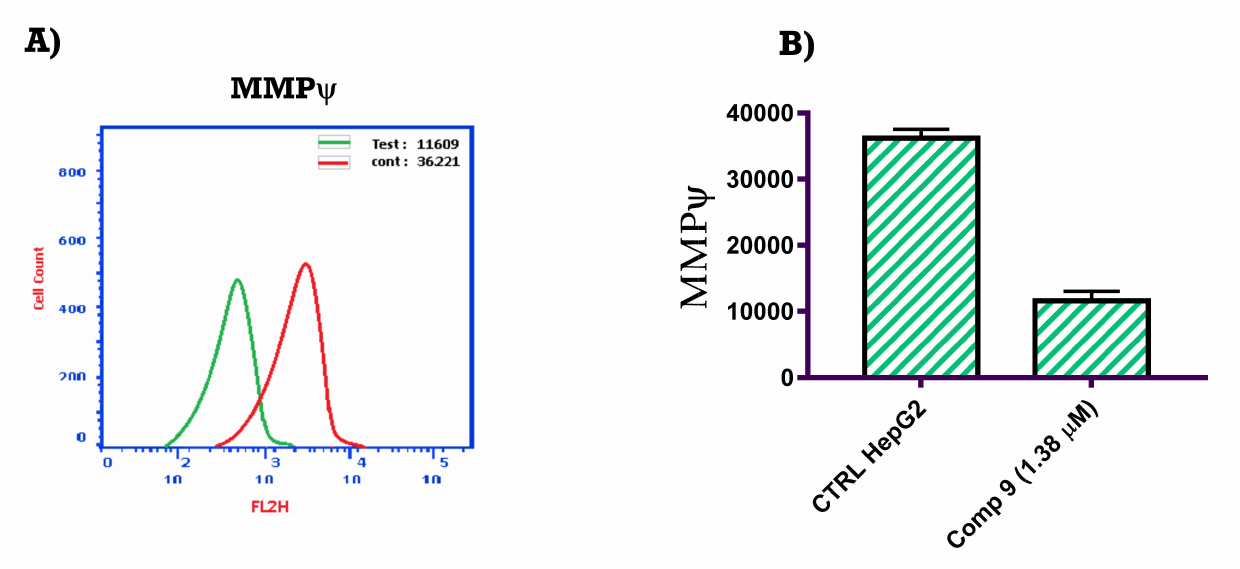
Figure 5. Compound 9 promotes MMP dissipation in HepG2 cells. ( A ) HepG2 cells were treated with 1.38 µ M of compound 9 for 48 h. MMP was quantized using image-based flow cytometry. ( B ) The quantification of MMP in HepG2 cells after treatment with compound 9 at its IC 50 concentration ( µ